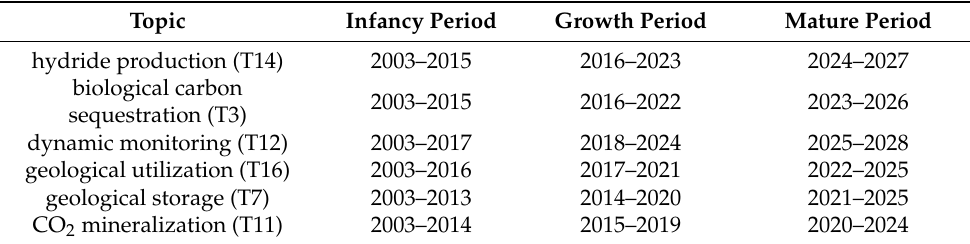
Table 5. Development stages of key CCUS technologies. Topic Infancy